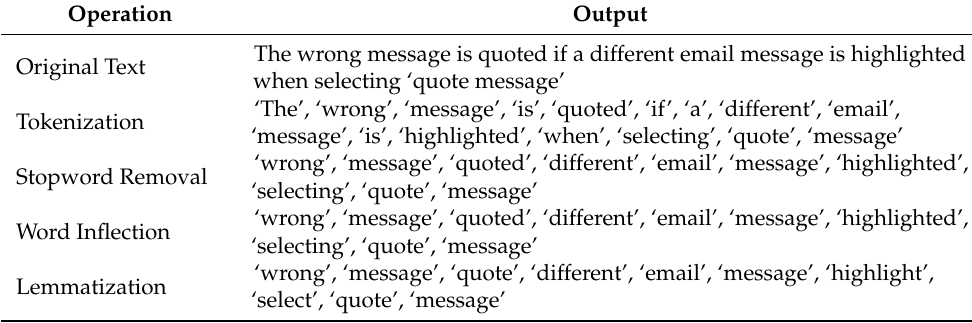
Table 2. Text preprocessing in MASP.